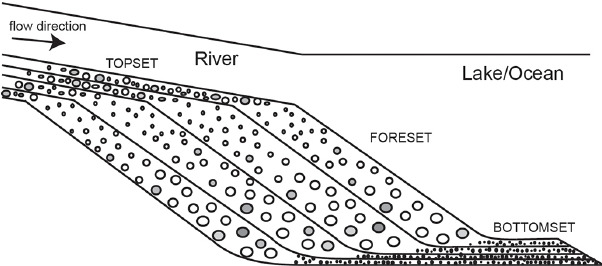
Figure 1. Schematic of a Gilbert-type delta (after Gilbert, 1890).